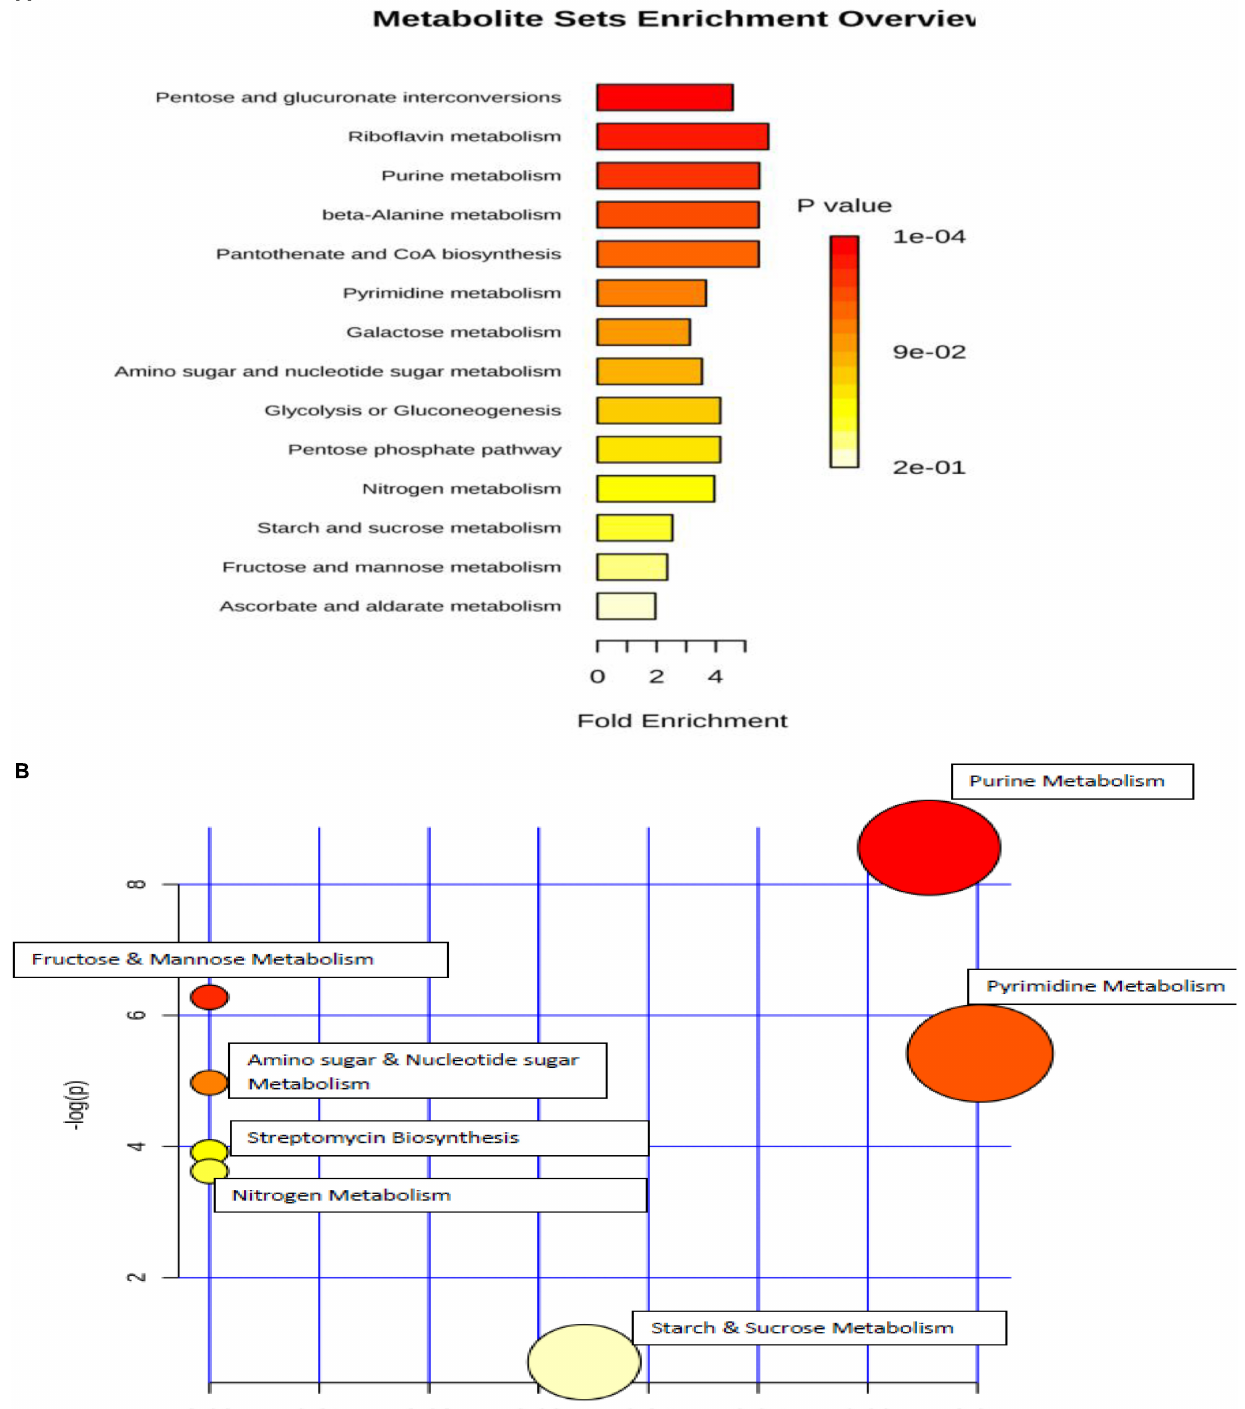
Frontiers in Microbiology |